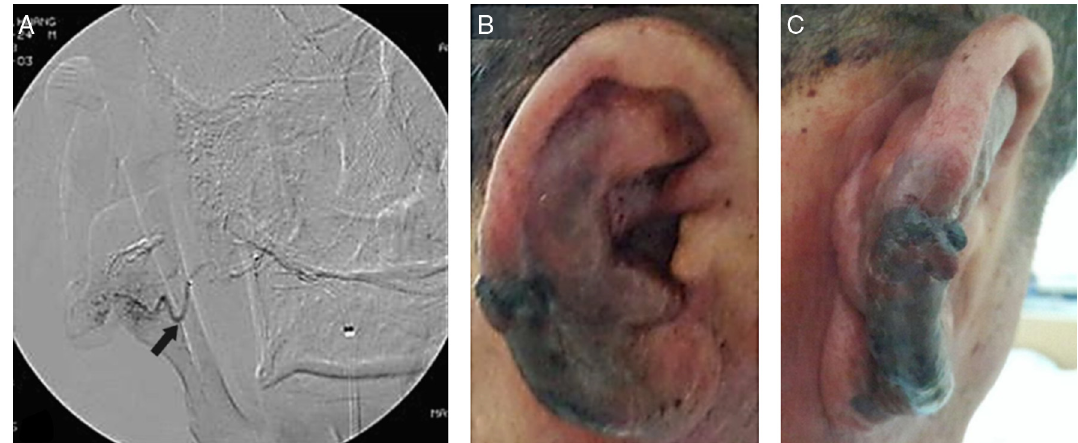
Figure 2 Preoperative therapeutic embolization using transfemoral cerebral angiography and gross ear findings 3 days after embolization: (A) transfemoral cerebral angiography revealed large tortuous vessels and innumerable small vessels. The principal feeder vessel of the arteriovenous malformation originated from the posterior auricular artery (black arrow), and was completely occluded with glue; (B) and (C) after embolization, the bleeding stopped, but ischemic necrosis of the skin